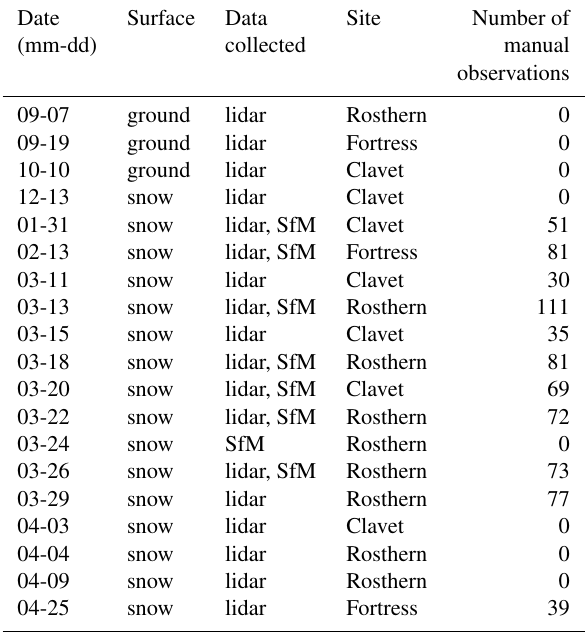
Table 1. Summary of data collection campaign, September 2018 to April